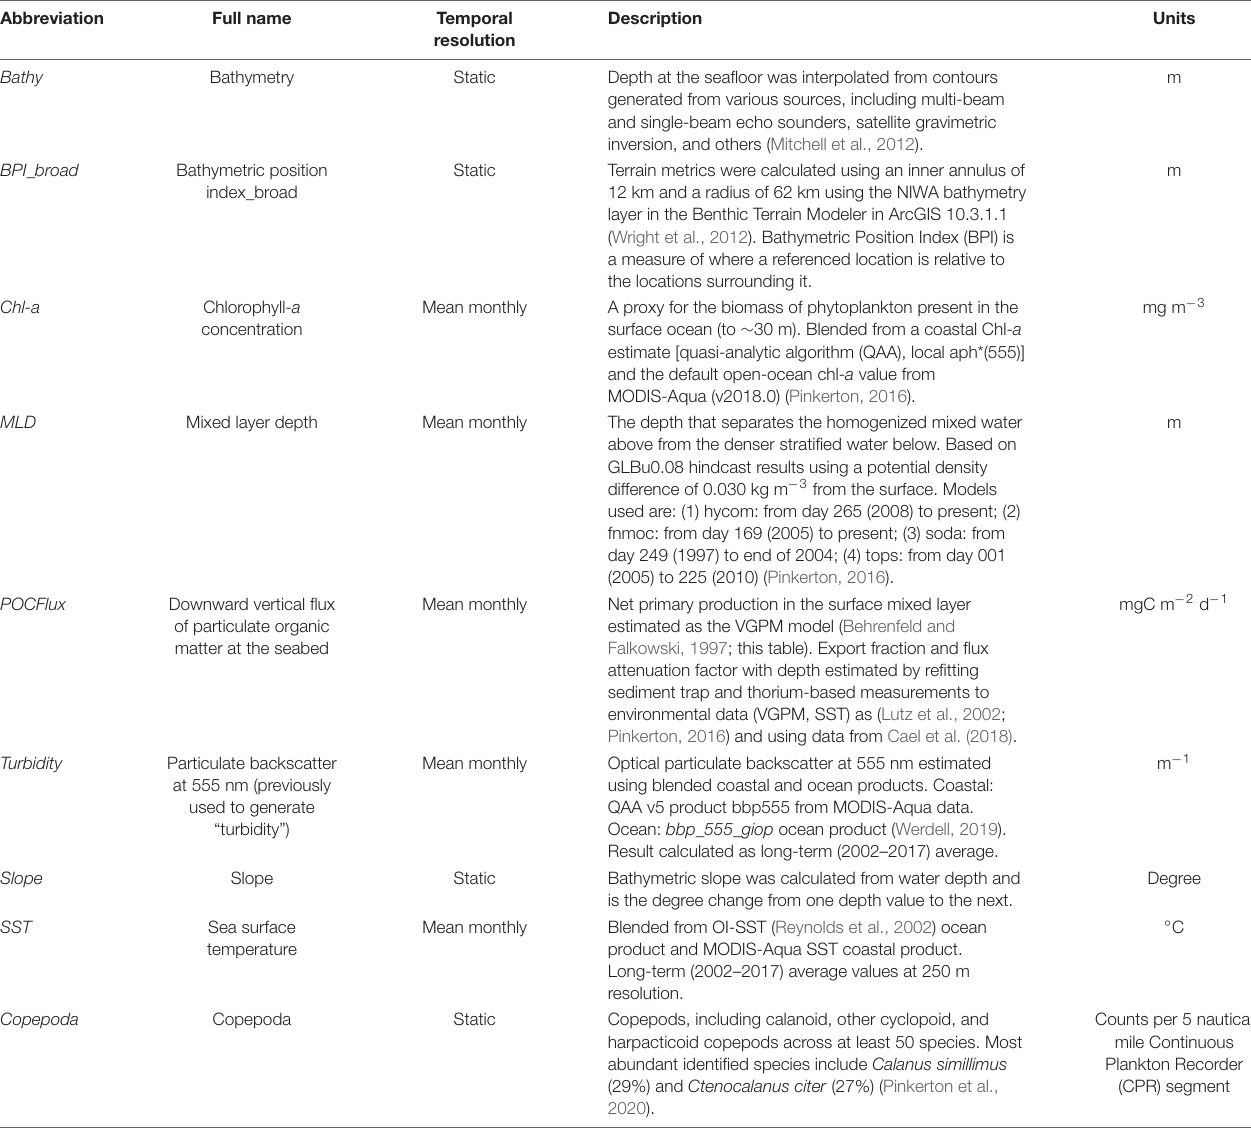
TABLE 1 | Spatial environmental and biotic predictor variables included in the final models, collated for species distribution models from Stephenson et al.